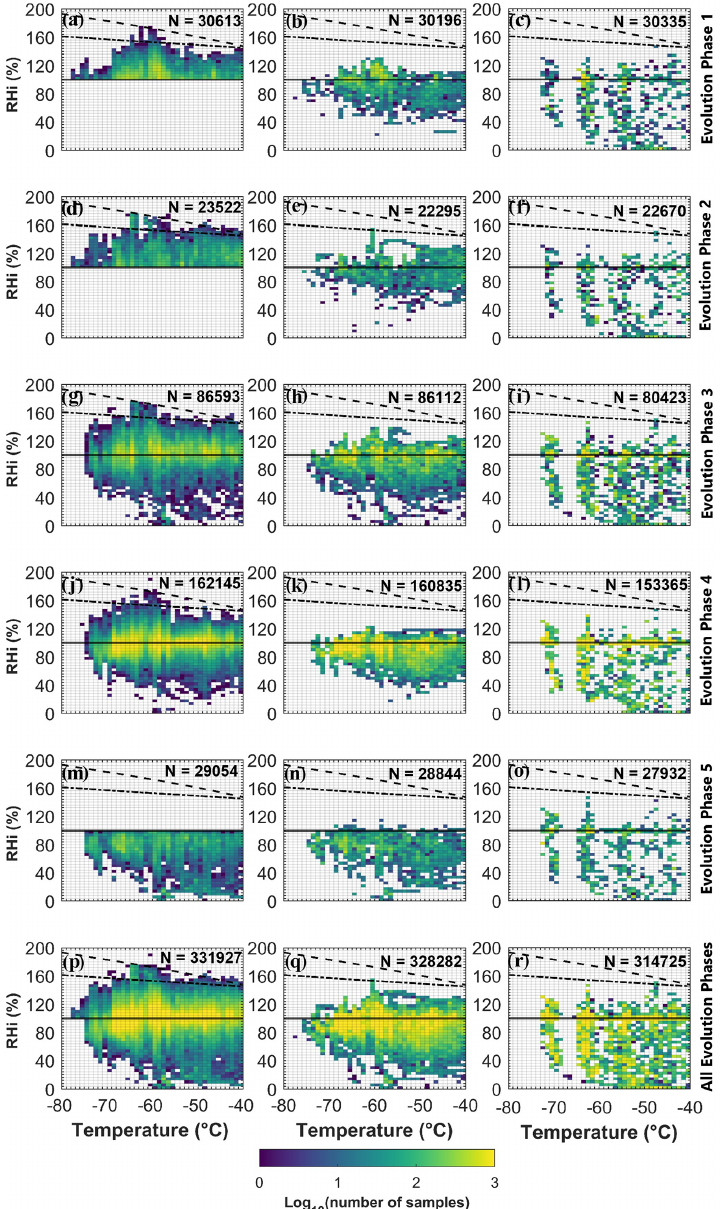
Figure 16. Distributions of RHi in relation to temperature for five evolution phases shown for 1s observations, 430s observations and simulations in columns 1, 2 and 3, respectively. Number of samples (in seconds) is shown in logarithmic scale. The solid line represents ice saturation, while the dashed line represents liquid saturation. The dotted–dashed line shows the homogeneous nucleation threshold for aerosols with a size of